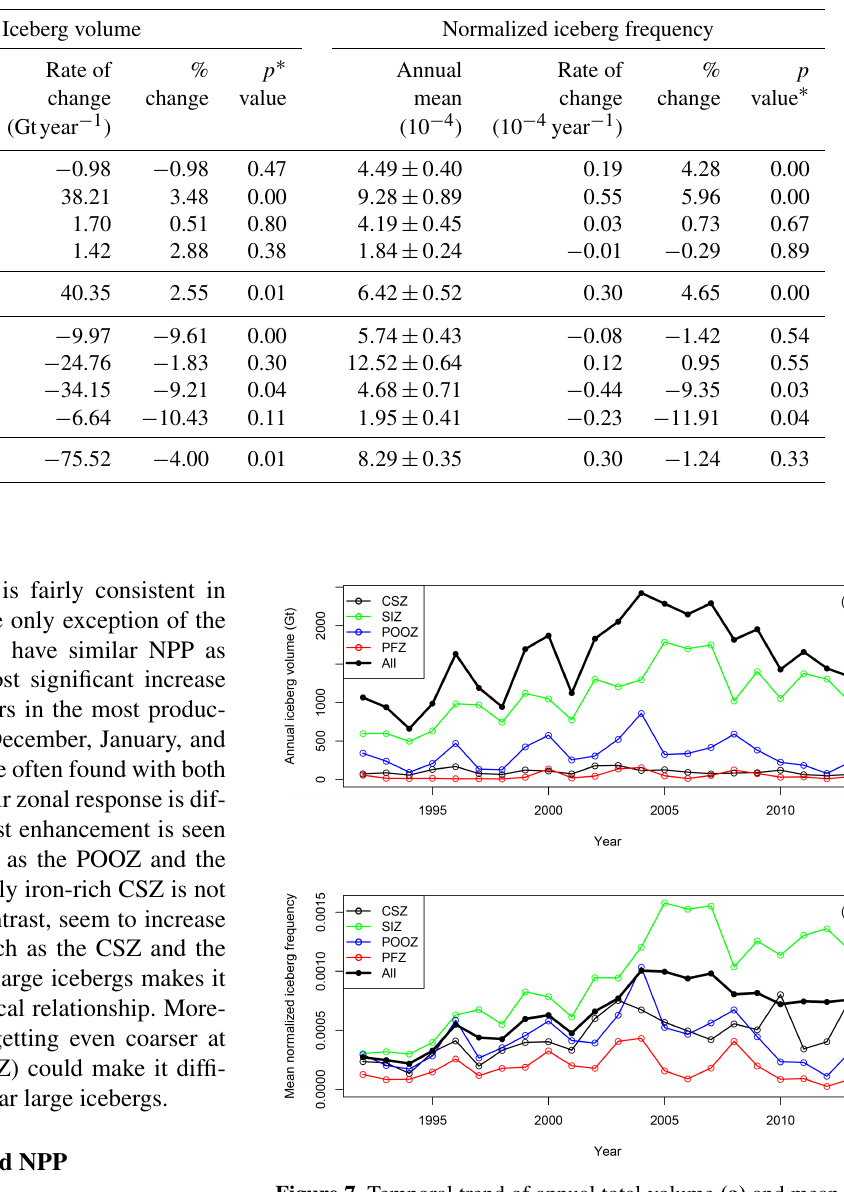
Figure 7. Temporal trend of annual total volume (a) and mean fre- quency (b) of small icebergs by ecological zones of the